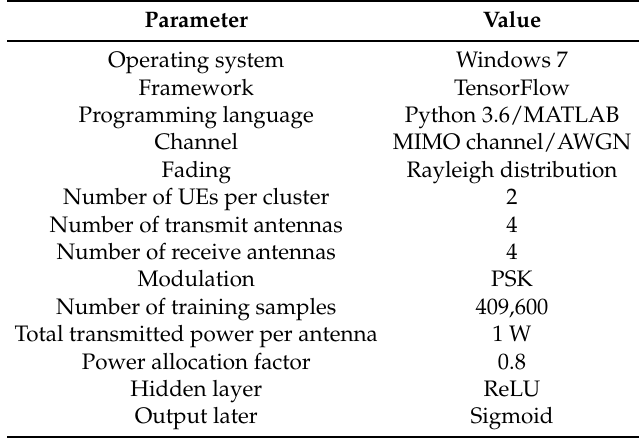
Table 1. Parameter settings used in the simulation. ReLU: rectified linear unit.